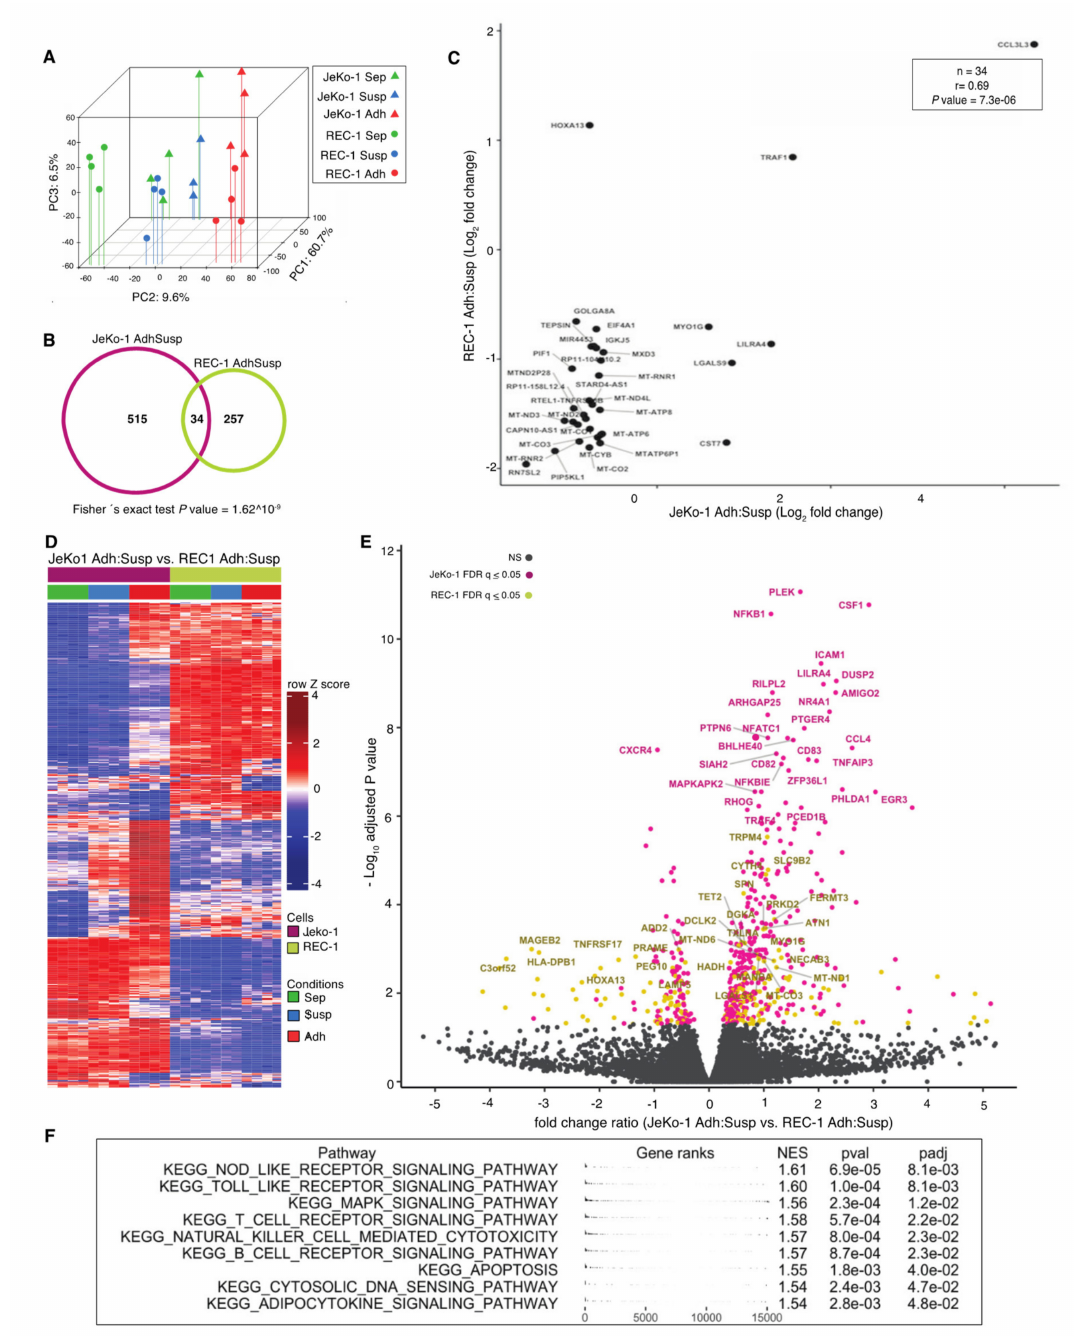
Figure 2. Adhesion to stroma a ff ects global gene expression di ff erently in JeKo-1 and REC-1 cells ( A ) Principle component analysis of genome-wide RNA transcription data from REC-1 (circles) and